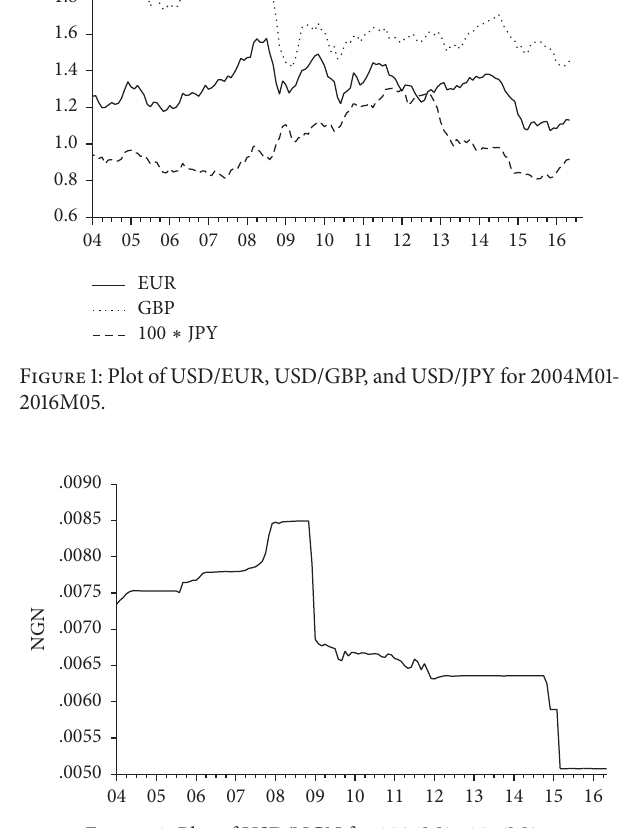
Figure 2: Plot of USD/NGN for